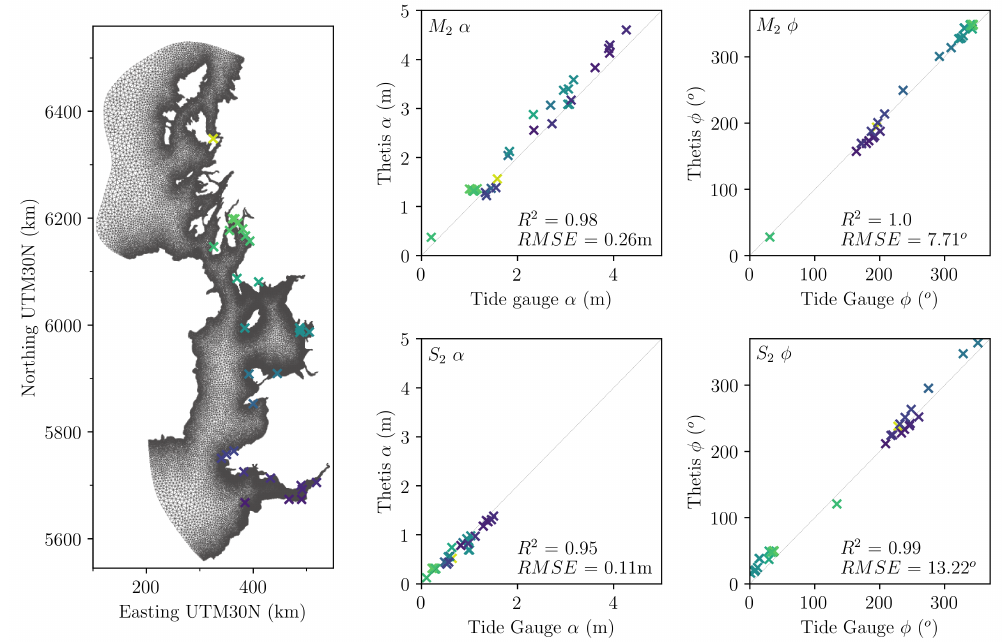
Figure 2. Unstructured mesh and computational domain including elevation data sampling locations for validation against BODC tide constituent data. R 2 correlation coefficient and Root Mean Square Error ( RMSE ) are computed between model and gauge data M 2 and S 2 tide constituent amplitude α (m) and phase φ ( ◦